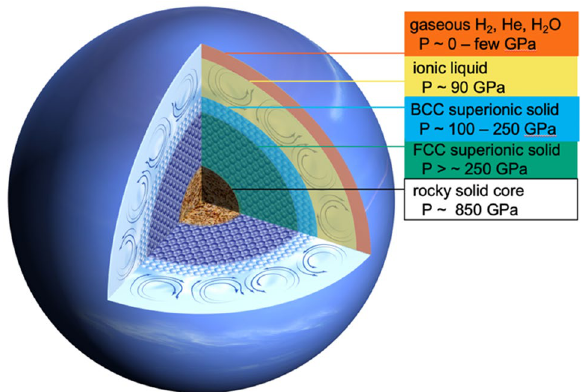
Figure 9. Neptune interior with multiple superionic layers. Ice giant interiors, like Neptune, have different layers of superionic ice. The molecular envelope of He, H 2 and H 2 O gas is largely insulating and the convecting ionic liquid layer may have ionic conductivities of a few to 100 (Ω cm) −1 . However, the superionic solid